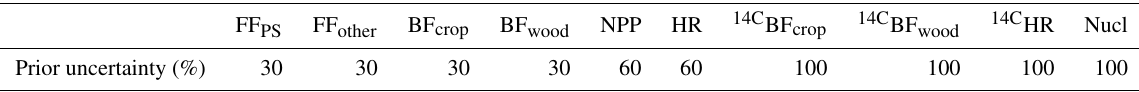
Table 3. Standard deviations of the prior uncertainties in 24h budgets of controlled fluxes or in controlled isotopic signatures for each control area.